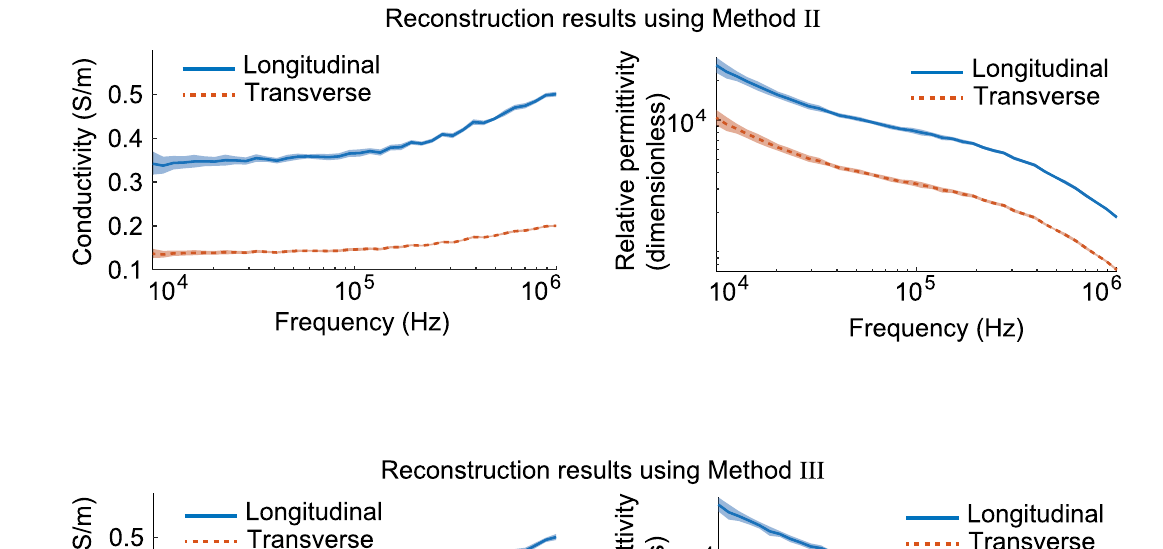
and method III (Eq. 29), (Eq. 30) with Z 1 , Z ⊥ 1 , Z 6 and Z ⊥ 6 . In this numerical experiment, when the angle mis- alignment was 1 degree and the noise SNR was 30 dB, the average and standard deviation of the estimated values were used by applying each method 10 times. The solid and dotted lines show true muscle electrical properties